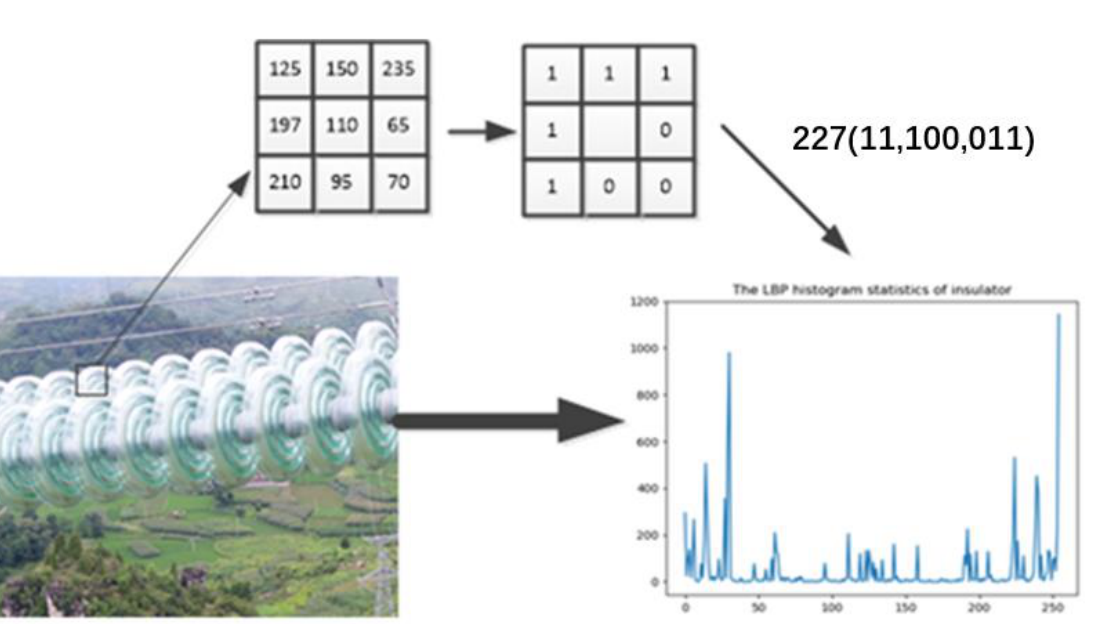
Figure 5. LBP feature histogram extraction .